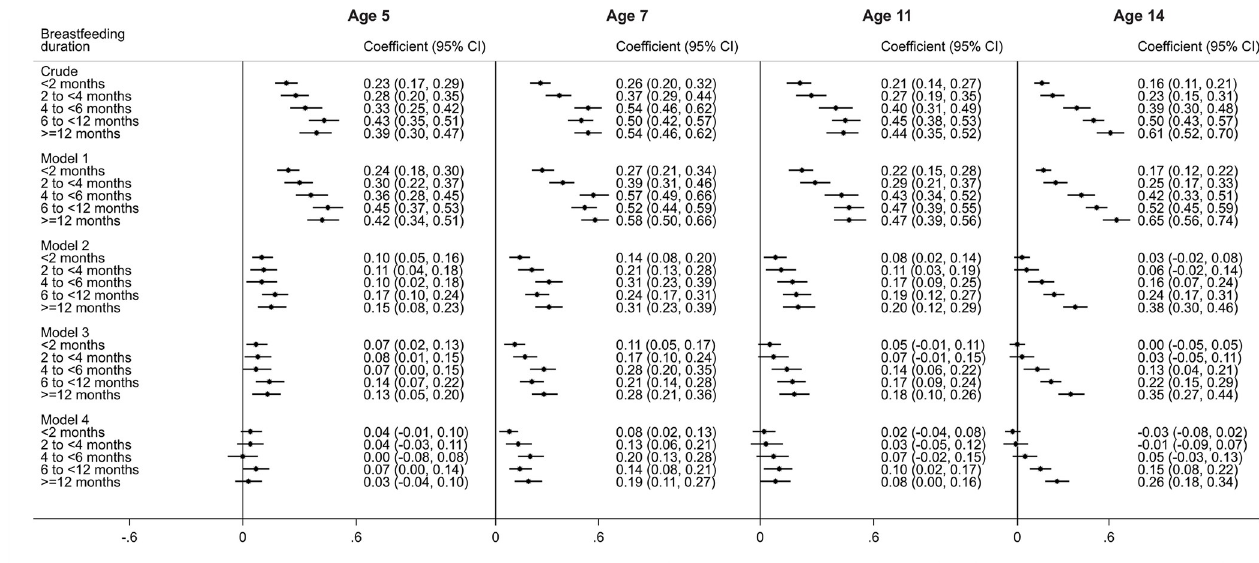
Fig 4. Association between breastfeeding duration (any breastfeeding) and standardised cognitive verbal scores (mean: 0; SD: 1)between ages 5 and 14, UK Millennium Cohort Study (n = 7,855). All categories of BF duration are compared to “Never breastfed” as the reference category. Model 1: Adjusted for gestational age at birth, maternal ethnicity and languages spoken in household. Model 2: Adjusted for Model 1 + Socioeconomic position (maternal education and highest social class in household). Model 3: Adjusted for Model 2 + other confounding factors (older siblings in household, maternal age, mother working outside the home, partnership status, and maternal smoking during pregnancy). Model 4: Adjusted for Model 4 + Maternal cognitive score.